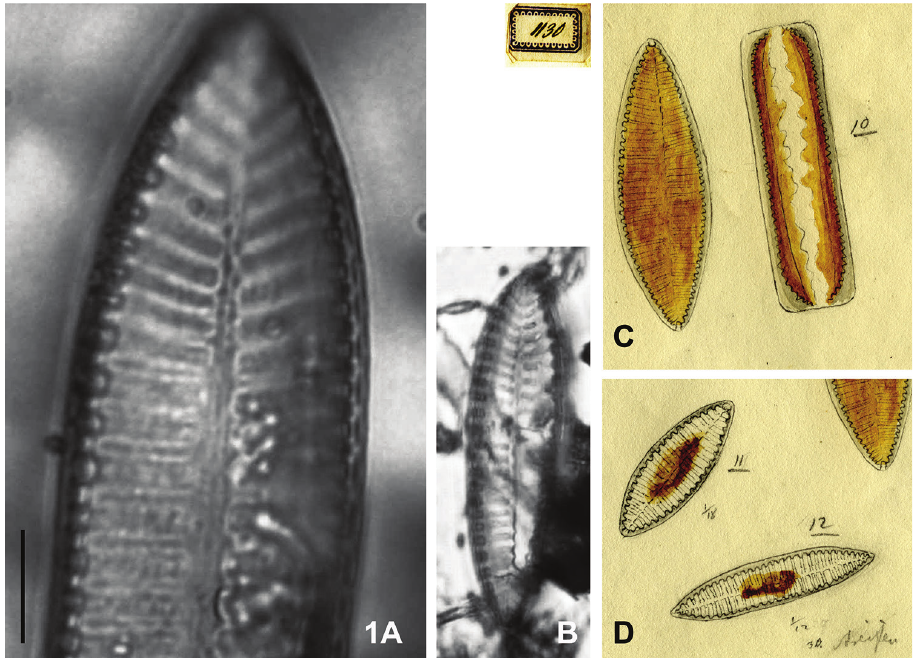
Figure 1. Iconella bifrons A–B Lectotype: BHUPM 540128-6 C–D Ehrenberg's drawing BHUPM 1130 showing different shapes of the same species in Ehrenberg's concept. Scale bar for A = 10 µm.